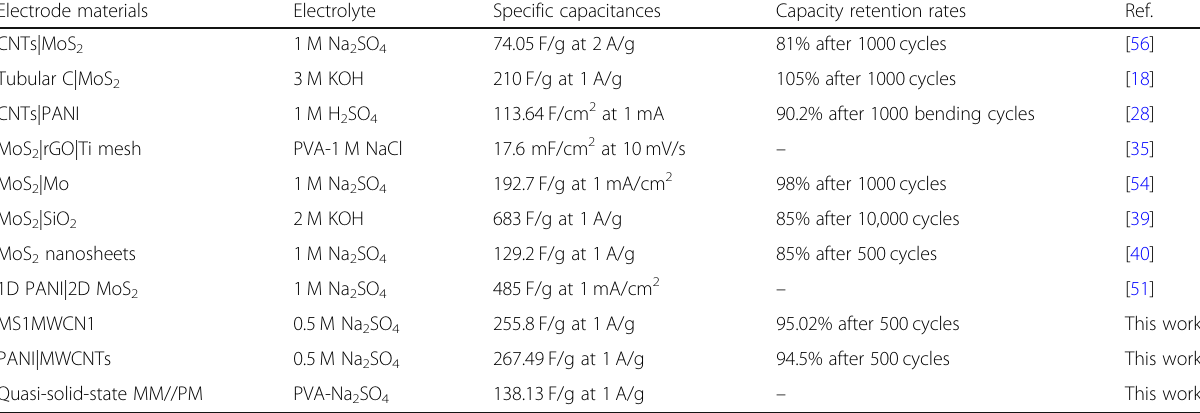
Table 1 A comparison of the characteristics of various MoS 2 or PANI for supercapacitors Electrode